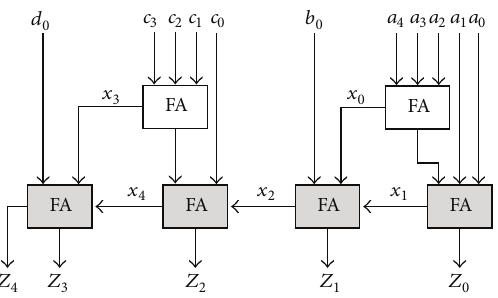
Figure 3: Boolean network for (1, 4, 1, 5; 5) GPC.